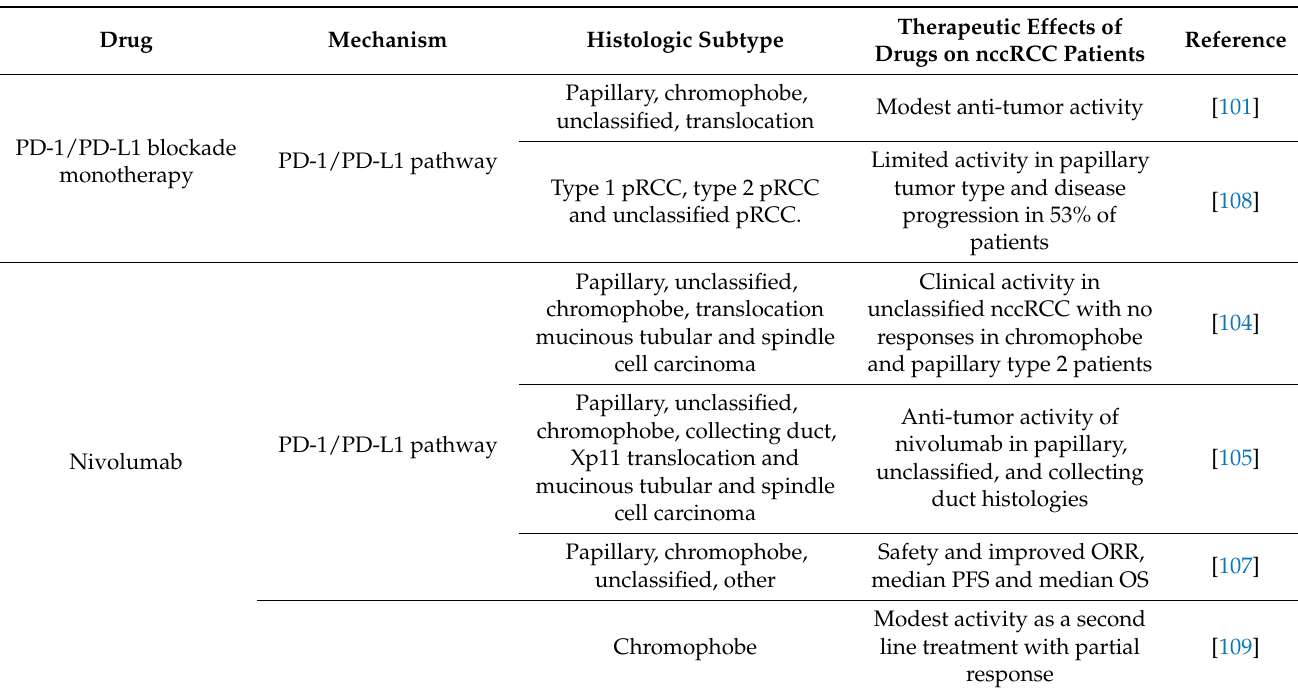
Table 3. Therapies with immune checkpoint inhibitor (ICI) pathways in non-clear cell renal cell carcinoma